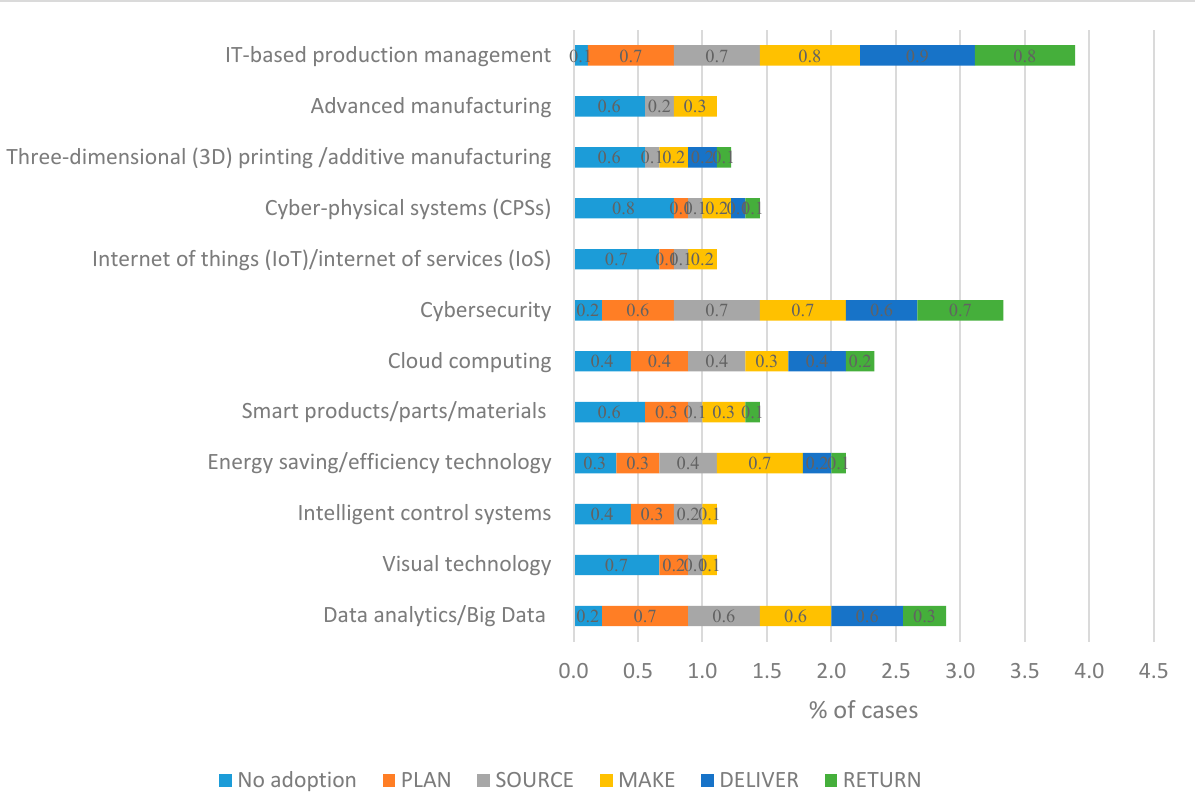
Figure 5. Advanced technologies adoption by SCOR processes (in percentage).